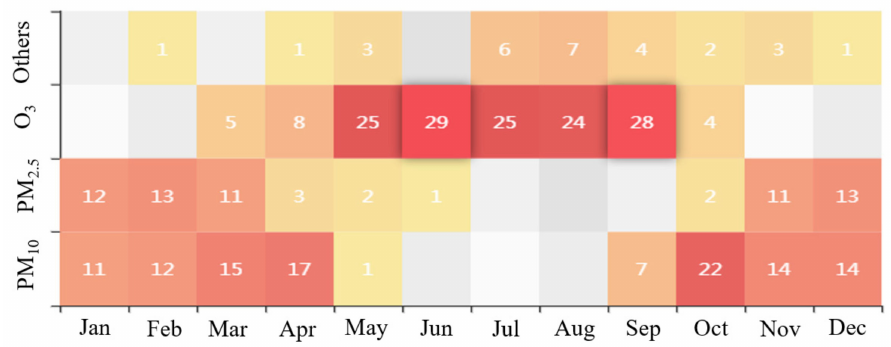
Figure 5. Frequency of the di ff erent pollutants being the primary pollutant in the di ff erent months.